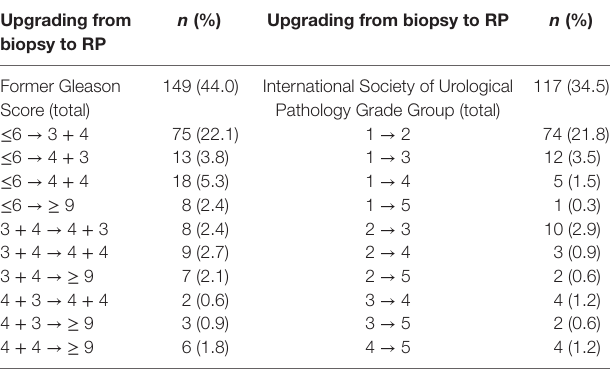
Table 5 | Frequency and distribution of upgrading from diagnostic biopsy to RP. Upgrading from biopsy to